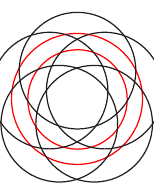
Figure 1: The 4-chromatic edge critical Koester graph K 1